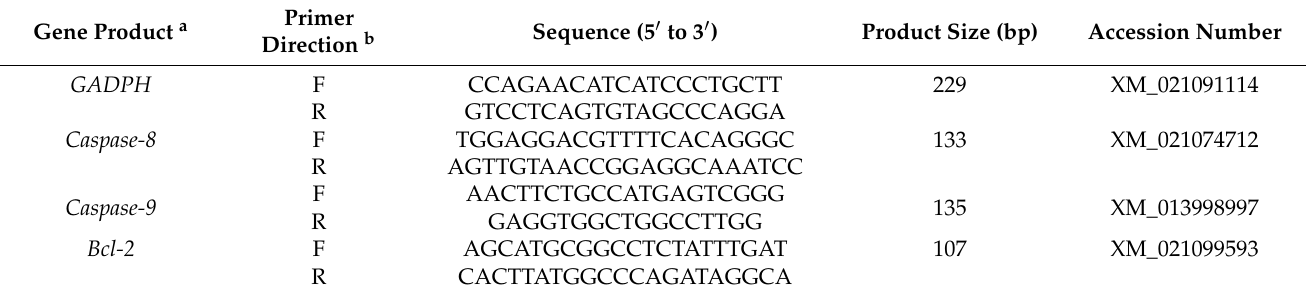
Table 1. Sequences of oligonucleotide primers used for real-time PCR, length of the respective PCR product, and gene accession